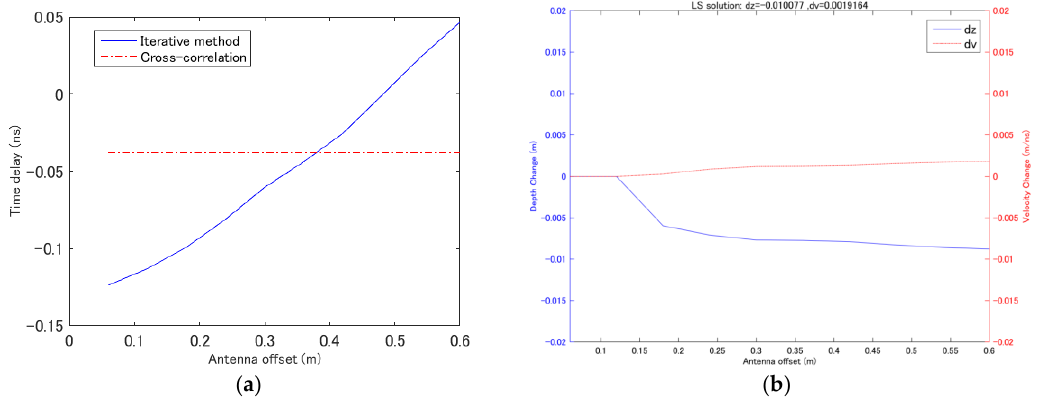
Figure 6. Simultaneous estimation of deviations in the propagation velocity and thickness with simulated data acquired using the FDTD method. ( a ) Time delay estimation using the cross-correlation method and the proposed iterative method. ( b ) Estimation results obtained using the proposed method with two antenna pairs; one with 0.05 m offset and all other antenna pairs. The least squares solution is given at the top of the figure.